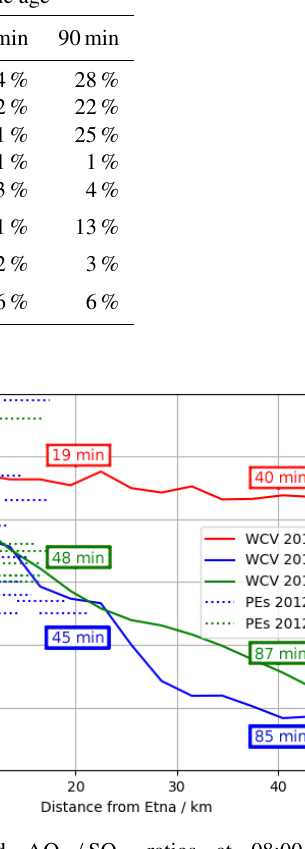
Table 4. Modelled relative fractions of bromine reduction by the various non-O 3 -forming reactions for parts of the plume at different ages ( ± 5min listed age) on 1 August 2012 at 08:00UTC. Fraction at plume age Reaction